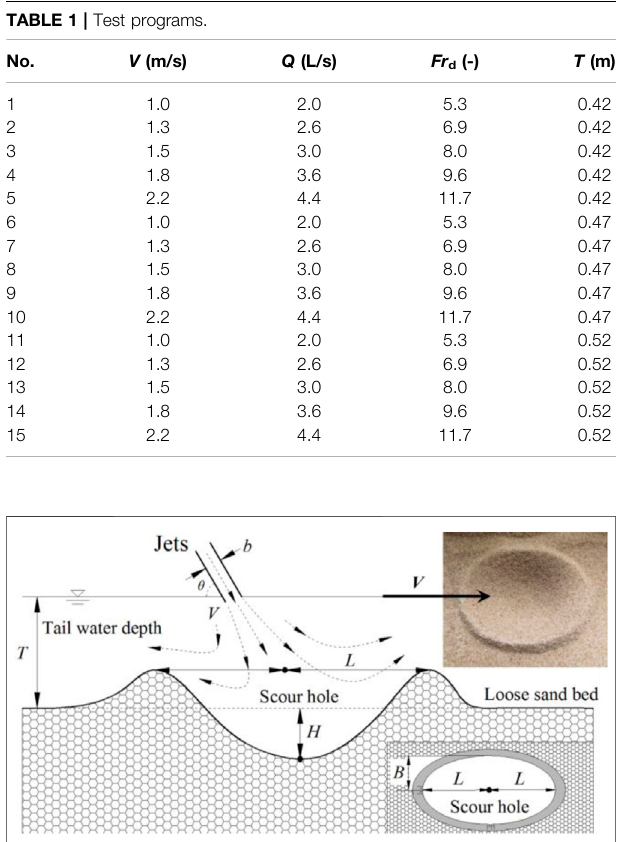
FIGURE 3 | De fi nition scheme with